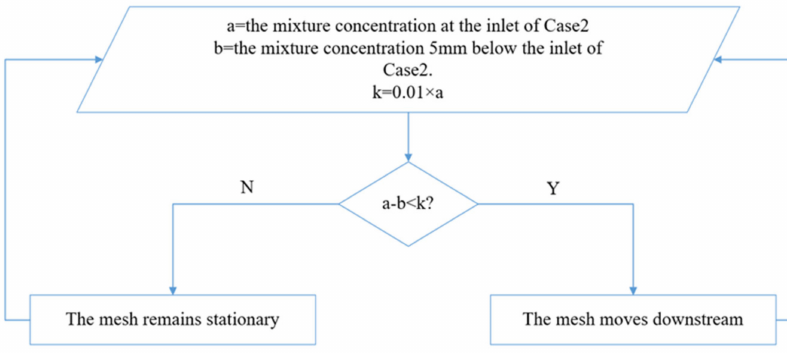
Figure 5. Mesh movement control